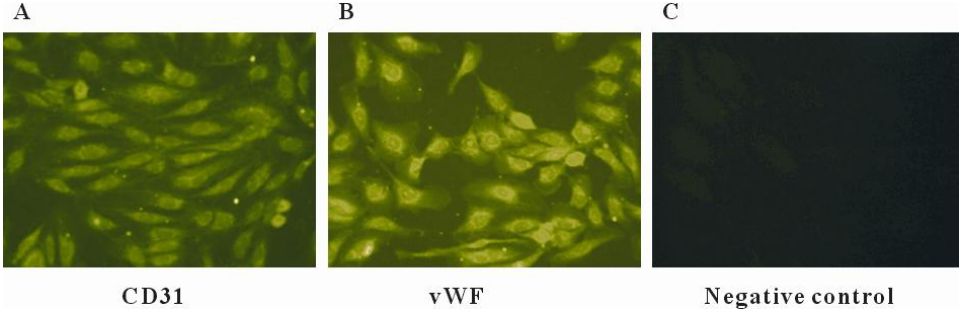
SUPPLEMENTARY FIGURE 1. Identification of primary HUVECs. Primary HUVECs were stained with antihuman CD31 (A) or von Willebrand factor (vWF) (B). Immunofluorescence assay showed that ≥95% cells isolated and cultured were positive. Rat lung fibroblasts stained with antirat vWF served as negative control